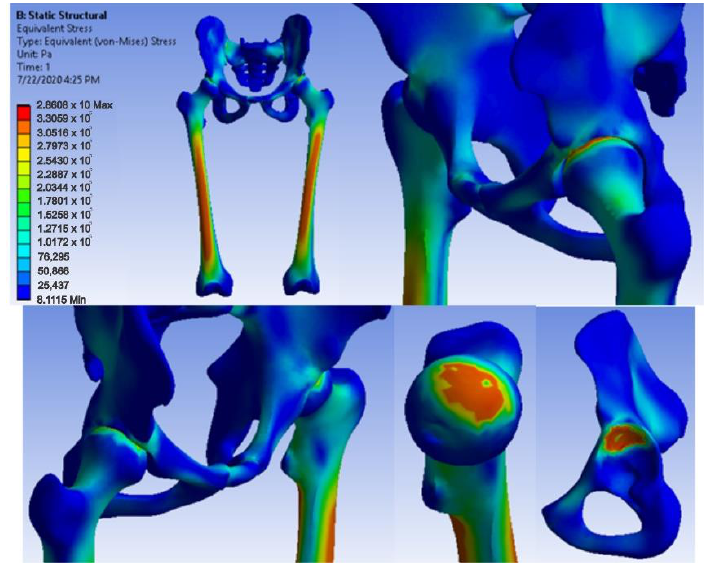
Figure 38. Stress maps for intact hip.